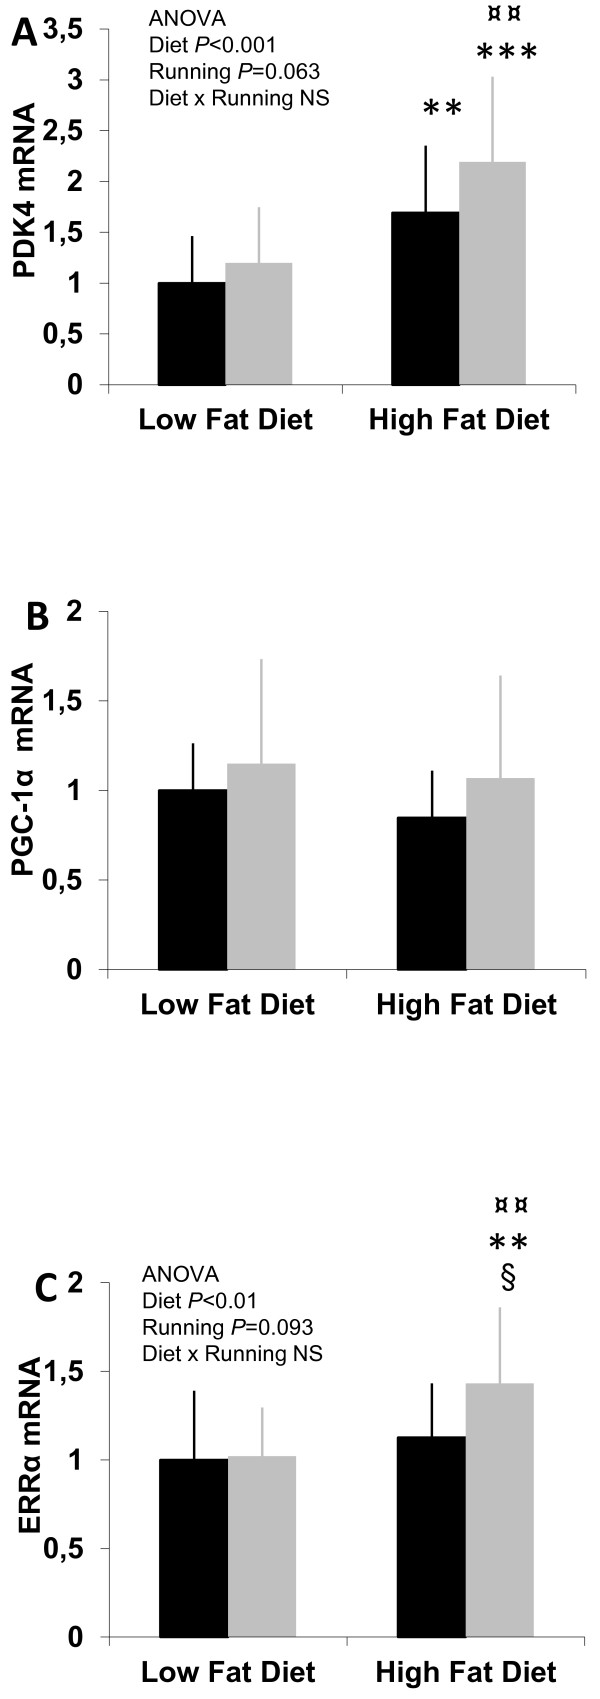
The mRNA expression levels measured with quantitative RT-PCR in gastocnemius muscle. (A) In the mRNA expression levels of PDK4 there was a statistical effect of diet. The expression levels were significantly higher in HF mice groups compared to LFsed animals and additionally in HFexe group compared to LFexe. PGC-1α (B) expression level differences did not reach statistical significance between any of the groups. Also the mRNA expression levels of ERRα (C) showed a statistical effect of diet. HFexe mice had significantly higher expression in ERRα compared to other groups. The results are expressed in relation to the LFsed mean value. n = 14-15 animals/group. ** = vs. LFsed (P < 0.01), *** = vs. LFsed (P < 0.001), § = vs. HFsed (P < 0.05), ¤¤ = vs. LFexe (P < 0.01), NS = non-significant (P > 0.1). Black bars = sedentary, grey bars = running.